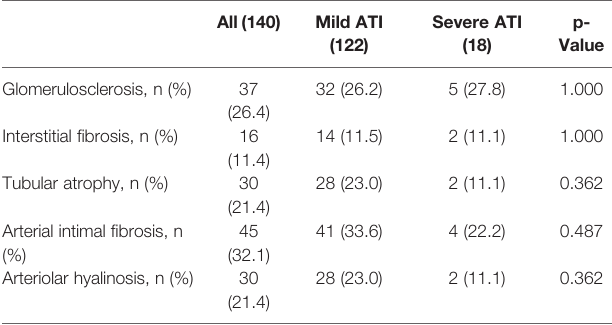
TABLE 6 | The chronic pathological lesions in pretransplant biopsy of grafts with severe ATI and mild ATI.